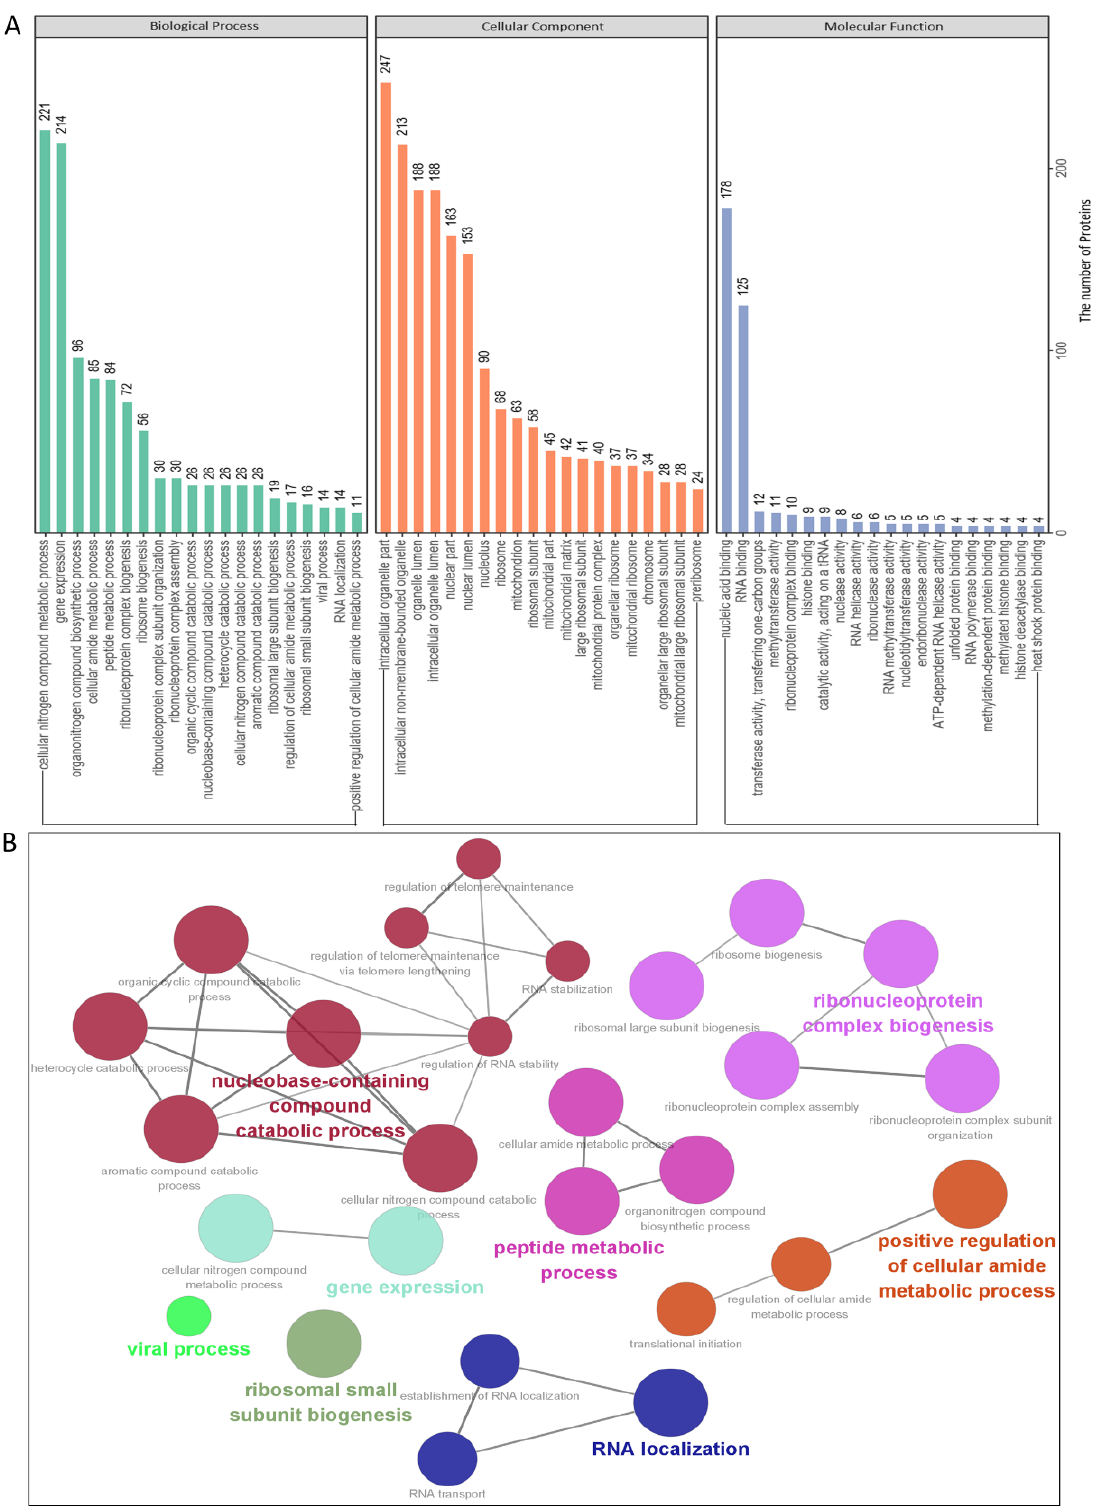
Figure 3. Gene Ontology analysis of the identified PEDV N protein–host interactome. ( A , B ) Repre- sentative over-represented GO terms of protein clusters and the GO distribution of unique proteins in the PEDV-infected cells were classified into three categories using the GOclue plugin in Cytoscape software, version 3.7.1. We have shown the significantly enriched terms based on the biological process (BP), molecular function (MF), and cellular component (CC) with p -values < 0.05. The Roman numerals represent the detailed GO terms, as shown in Supplementary Table S3.